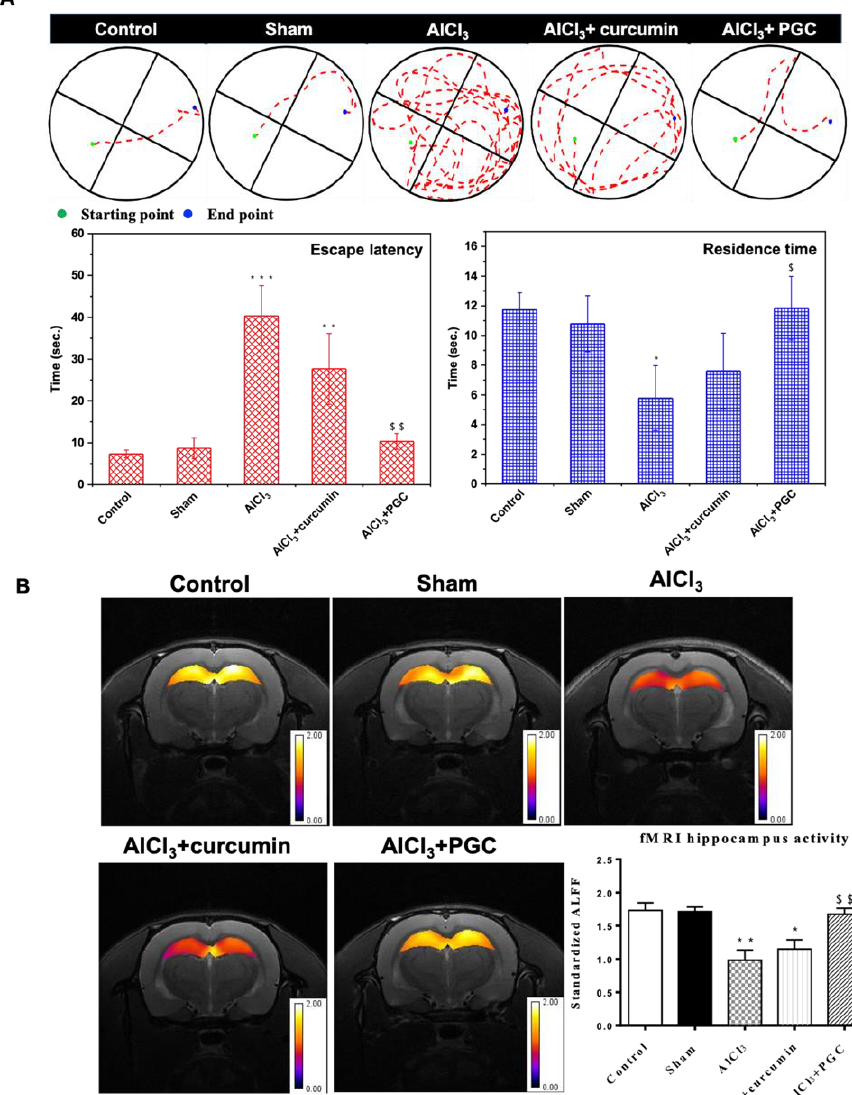
Figure 7. The Morris WM test and determination of hippocampal activity by fMRI. ( A ) The MWM track of the normal rats (control), PBS injection (Sham), AlCl 3 -induced AD rats (AlCl 3 ), curcumin-free drug- treated AD rats (AlCl 3 + curcumin), and PGC treatment (AlCl 3 + PGC). The starting point (blue) to endpoint (green) of all the tested rats was the same ( n = 6, * p < 0.05 compared with control, ** p < 0.01 compared with control, *** p < 0.001 compared with control, $ p < 0.05 compared with AlCl 3 group, $$ p < 0.01 compared with AlCl 3 group). ( B ) fMRI analysis of brain activity on rats’ hippocampus. The statistical parametric mapping of the brain activity in the rat hippocampus. The brain activity was determined by the intensity of brightness in the ROI on single shot GRE-EPI images. The intensity of brightness in the ROI of the AlCl 3 group was about 50% lower than that of the control and AlCl 3 + PGC group ( n = 6, * p < 0.05 compared with control, ** p < 0.01 compared with control, $$ p < 0.01 compared with AlCl 3